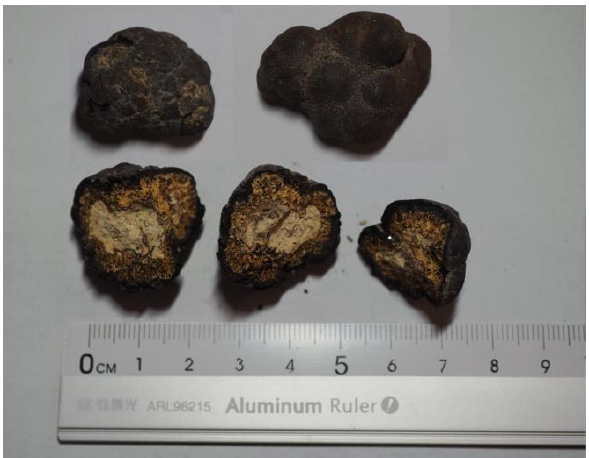
Figure 1. Morphology of ferromanganese nodule samples.